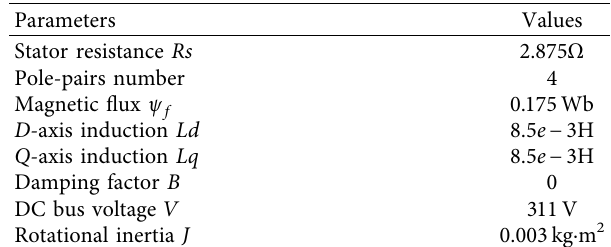
Figure 1: SPMSM speed regulation system based on NSTA-SMC. Table 1: SPMSM